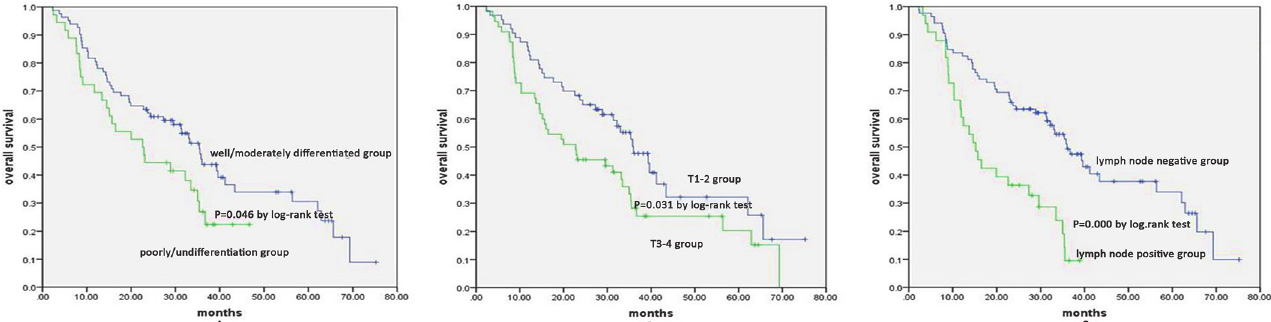
Fig 4. Univariate analysis of tumor grade and T and N status. A.Five-year OS of the well/moderately differentiated group was better than that of the poorly/undifferentiated group (30.5% vs. 22.4%, P = 0.046); B. Five-year OS of the T1 – 2 group was better than that of the T3 – 4 group (32.2% vs. 20.3%, P = 0.031); C. Five-year OS of the lymph node negative group was better than that of the lymph node positive group (33.9% vs. 9.5%, P =